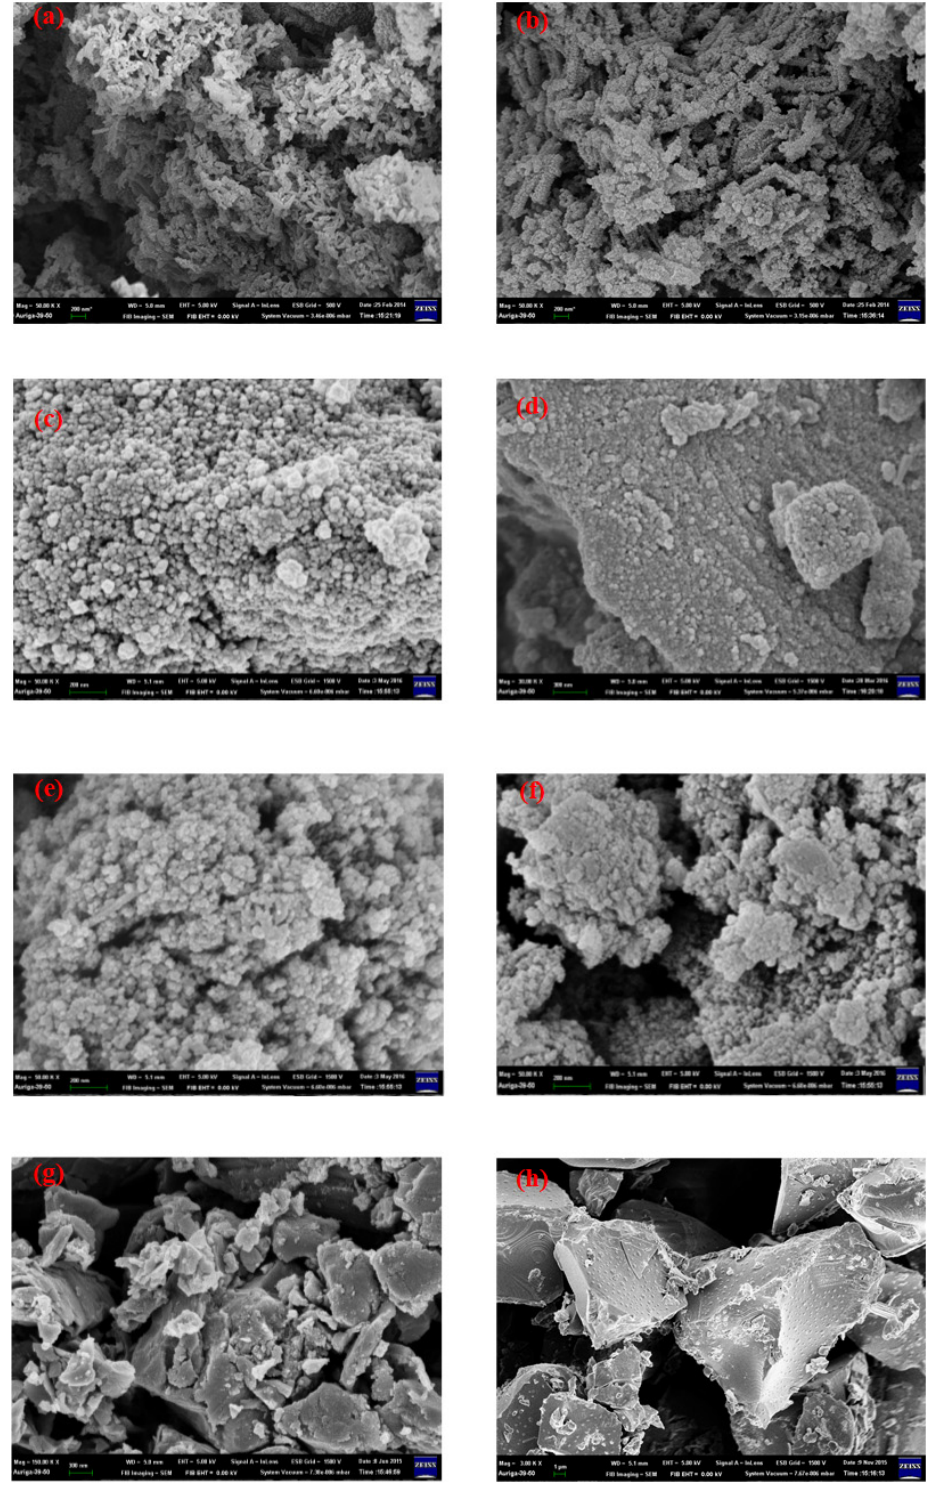
Figure 4. SEM micro-pictures of PANI and various iron compounds ( a ) PANI(Em) ( b ) PANI(Em)/Fe 3 O 4 ( c ) Fe 3 O 4 ( d ) Fe 3 O 4 (OA) ( e ) PANI(EB)/Fe 3 O 4 ( f ) PANI(EB)/Fe 3 O 4 (OA) ( g ) FeNC ( h ) FeNC(OA).